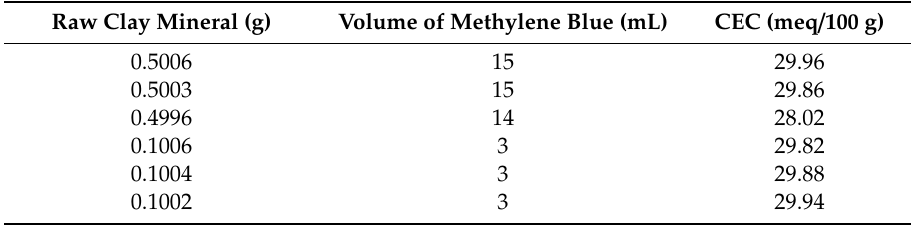
Table 2. Cationic exchange capacity (CEC) results for the raw clay